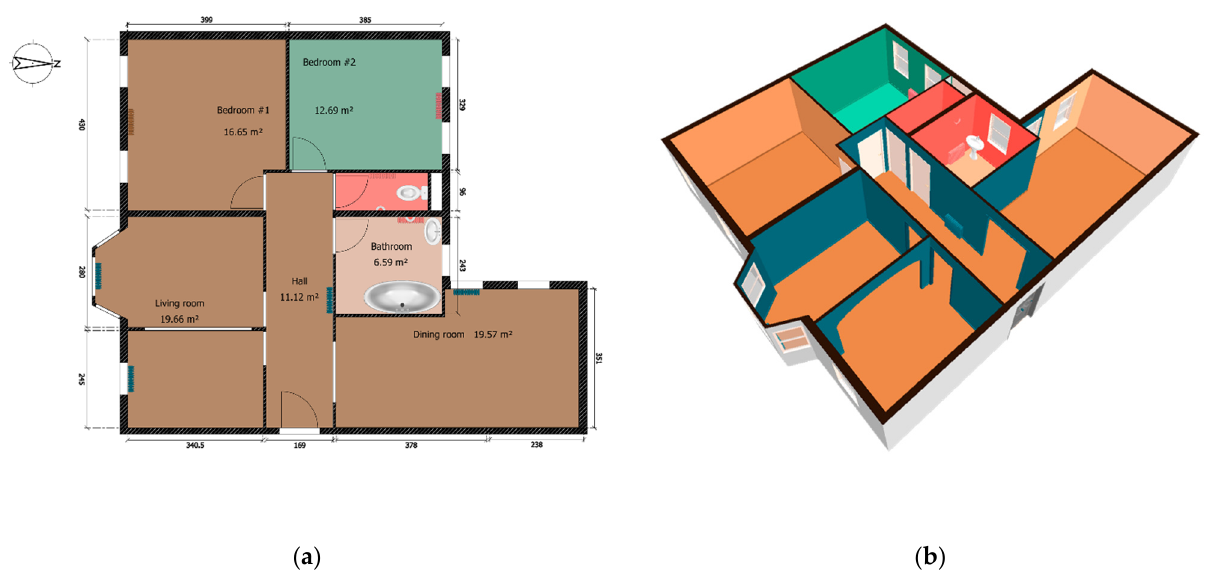
Figure 12. Redesign of the apartment proposed by the architect after receiving the wheelchair user’s report: ( a ) 2D and ( b ) 3D plan of the apartment.